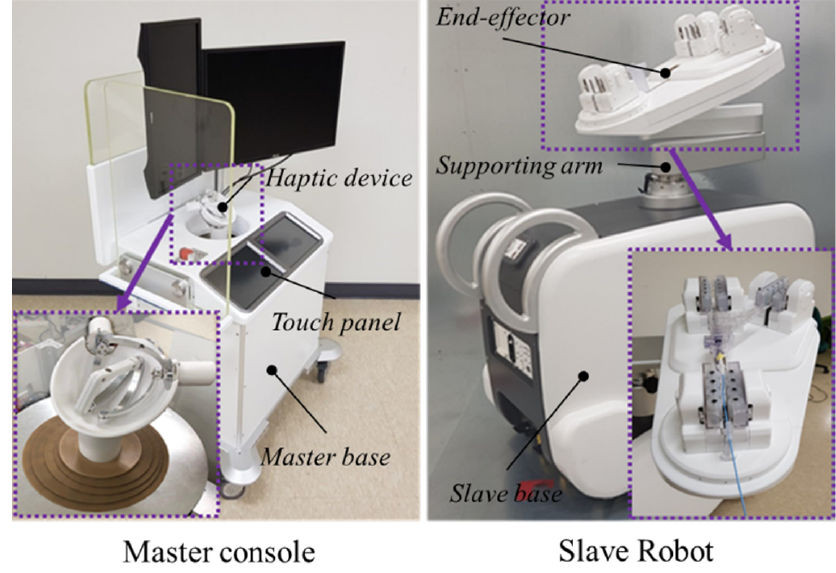
Figure 5. Clinical prototype of the robot system.